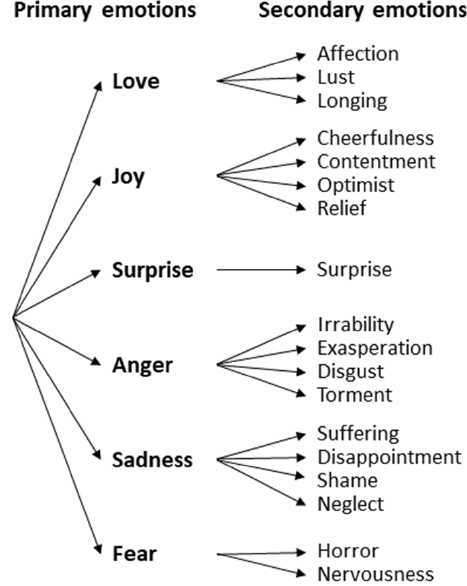
Figure 3. Parrots’ classification of Figure 3. Parrots' classification of emotions.